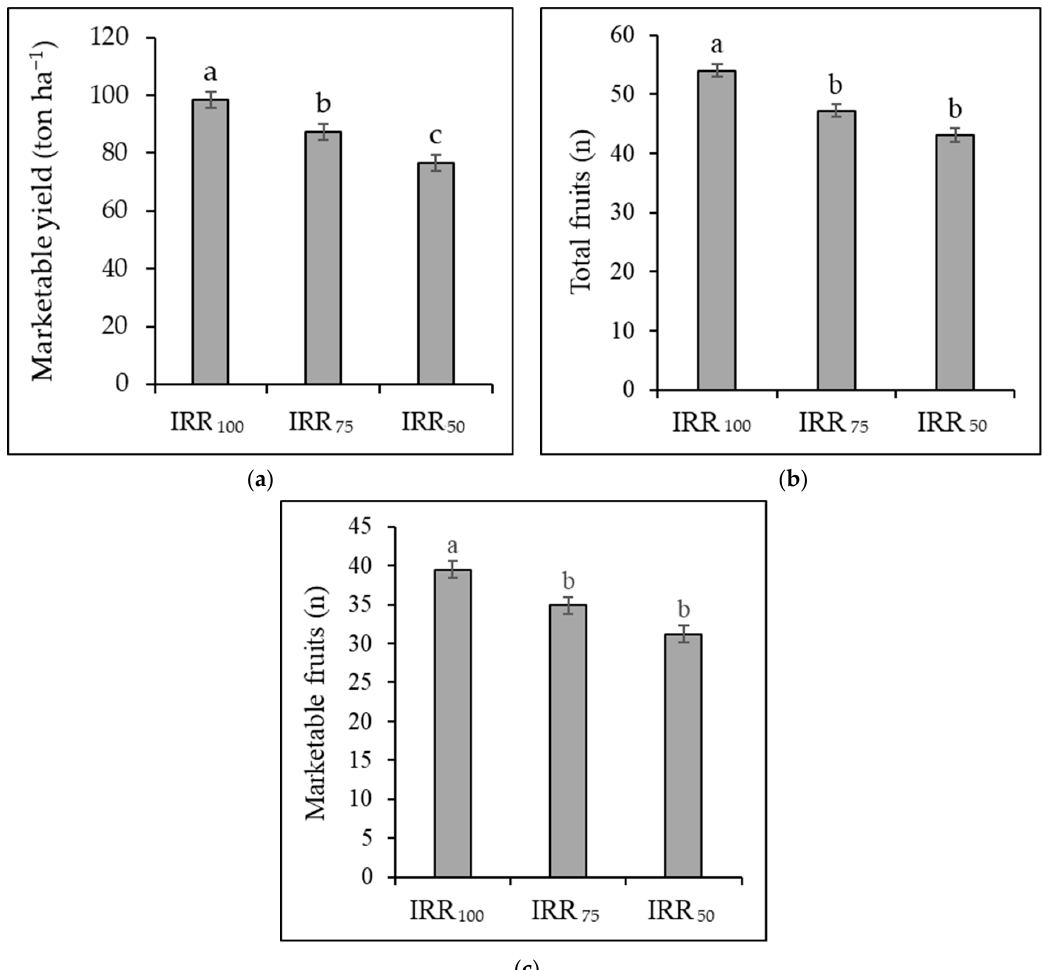
Figure 1. Effect of restoration of 100%, 75%, and 50% of ET c as a consequence of irrigation treatments (IRR 100 , IRR 75 , and IRR 50 , respectively) on ( a ) marketable yield and ( b ) total and ( c ) marketable fruits produced by plants. Different letters indicate significant differences at p < 0.05. Vertical bars represent standard errors.